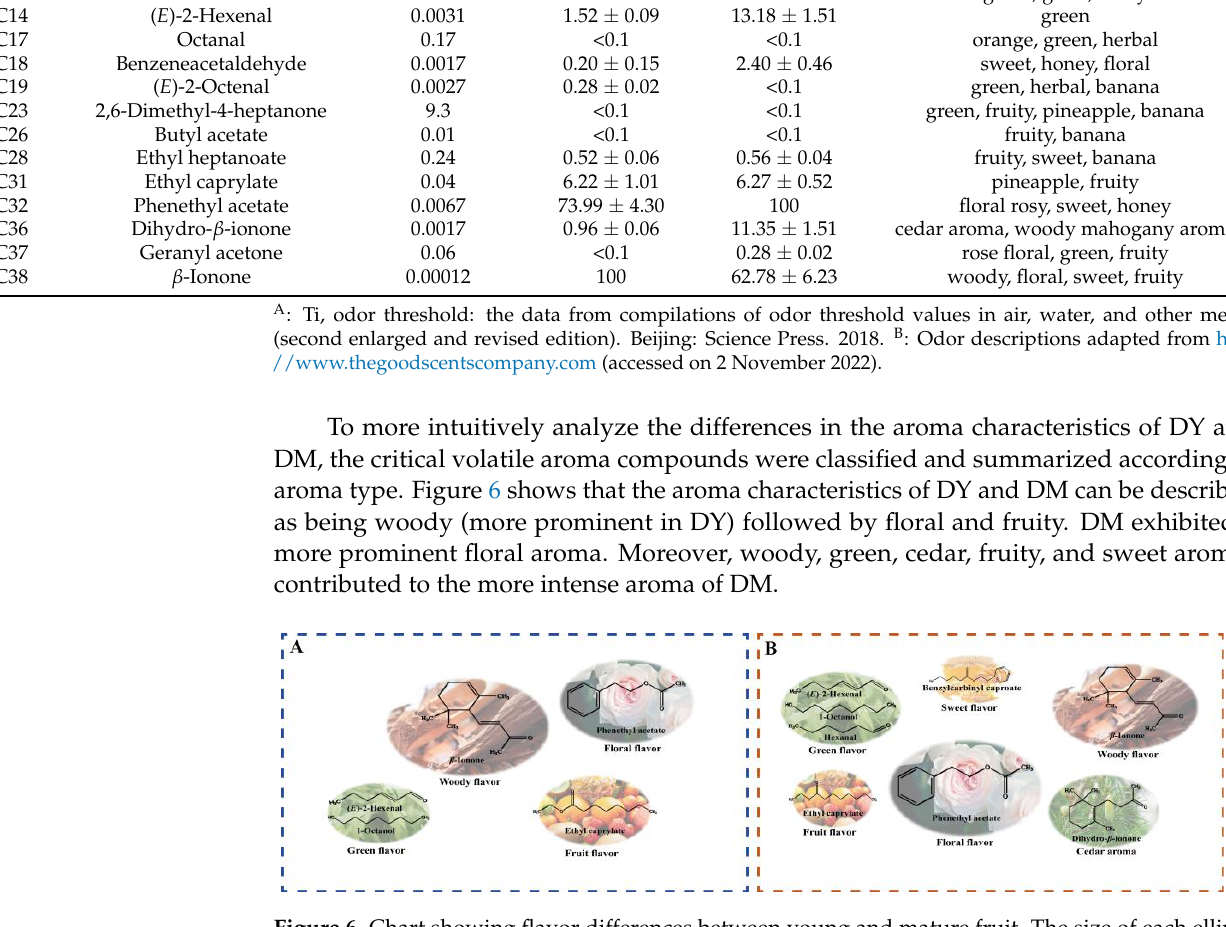
Figure 6. Chart showing flavor differences between young and mature fruit. The size of each el- lipse only indicates the strength of each type of aroma. Main flavors in ( A ) DY and ( B ) DM